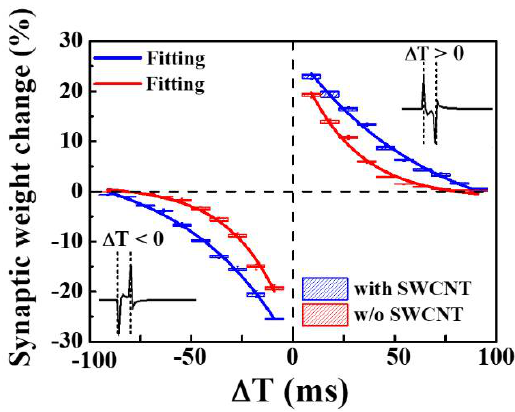
Figure 8. The STDP for the excitatory response mode of chitosan nanocomposite memristors with and without SWCNT random networks. The inset show illustrations of the spike signals.